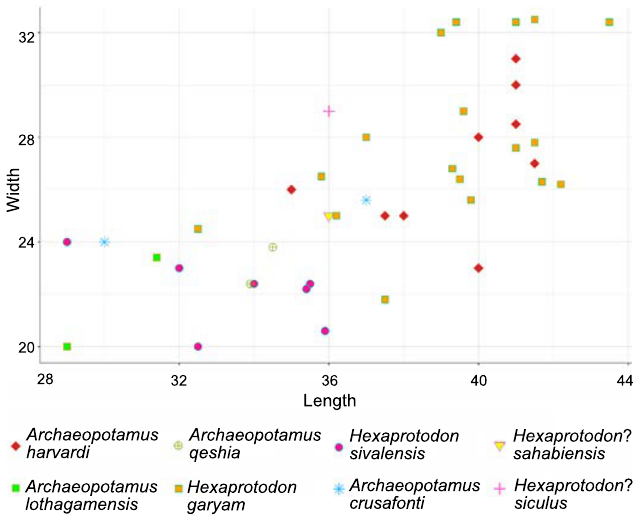
Fig. 7. Length-width diagram (in mm) of p4 in different hippopotamid spe- cies. Measurements from the literature (see Table 1).